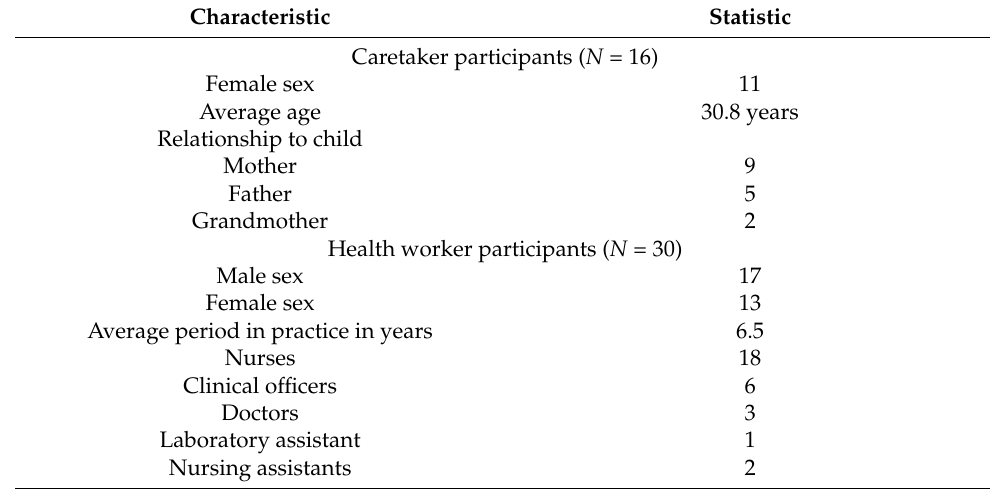
Table 2. Demographic characteristics of caretakers and healthcare providers.